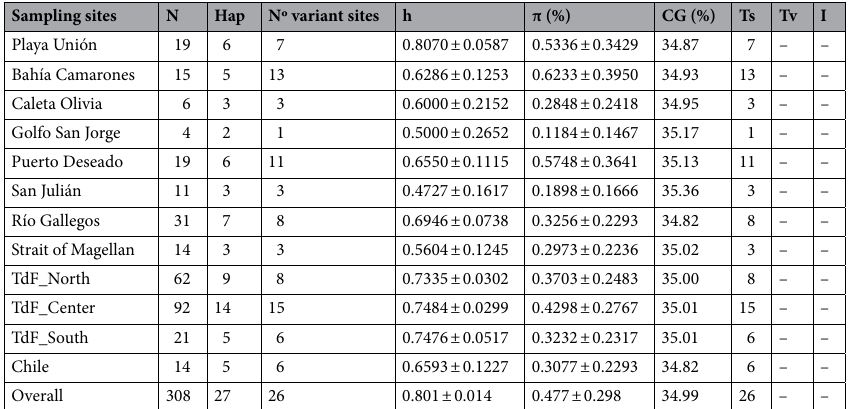
Table 1. Summary of mitochondrial DNA control region (423 bp) data of Commerson’s dolphin ( Cephalorhynchus commersonii ) for each sampling site (including data from Cipriano et al. 41 and Pimper et al. 42 ). N = sample size, Hap = Number of haplotypes, h = Haplotype diversity, π = Nucleotide diversity, CG = Cytosine and Guanine percentage, Ts = transitions, Tv = transversions, I = indels, TdF = Tierra del